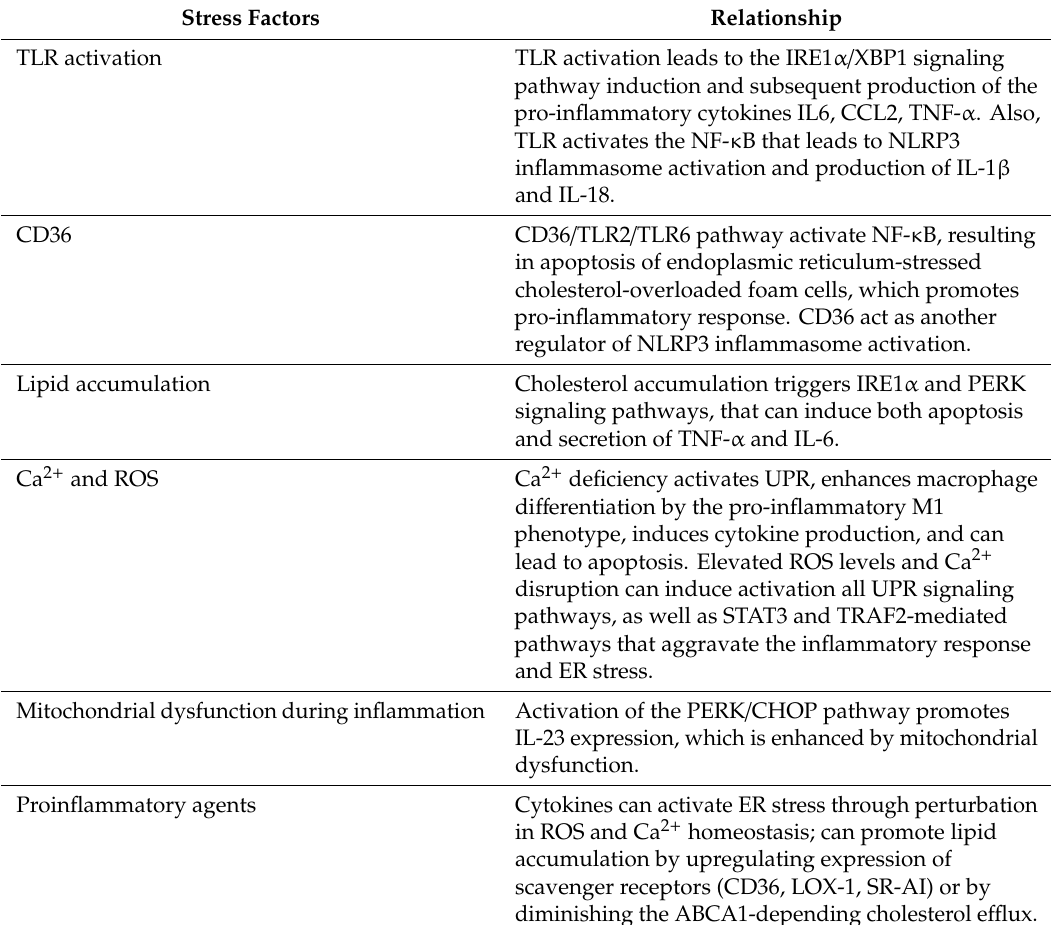
Table 4. Common stress factors for ER stress, lipid accumulation and inflammation and complex relationship between these